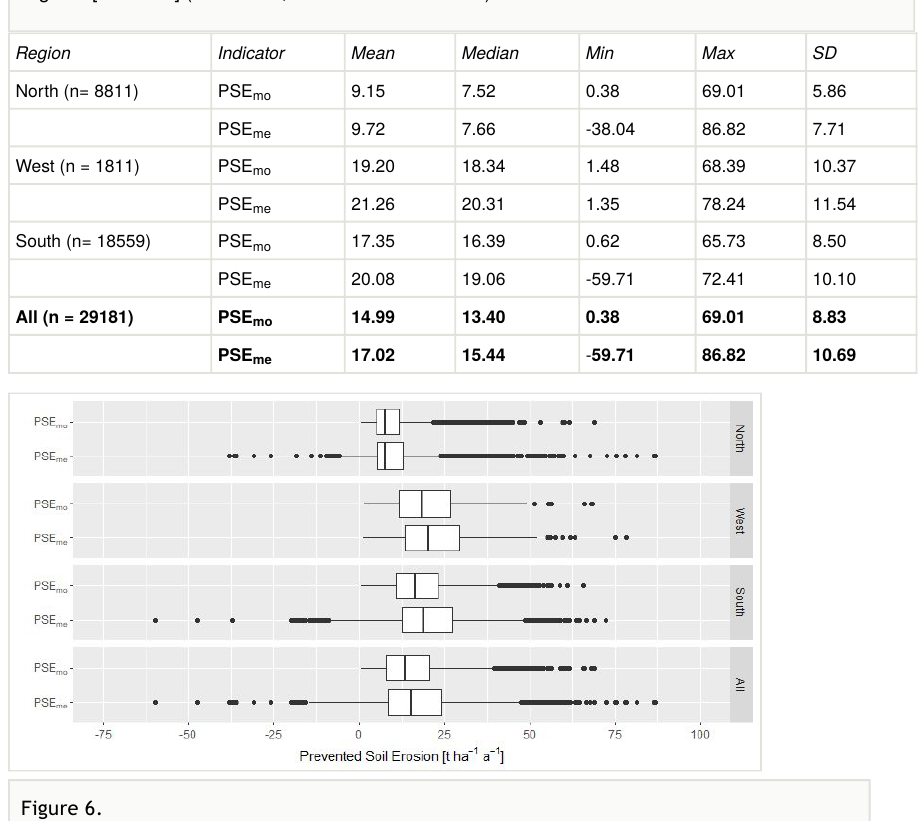
Figure 6. Boxplots for the indicators representing the prevented soil erosion (PSE : based on modelled actual soil loss data, PSE : based on measured actual soil loss data), grouped by regions [t ha a ] (n = 29181, number of raster